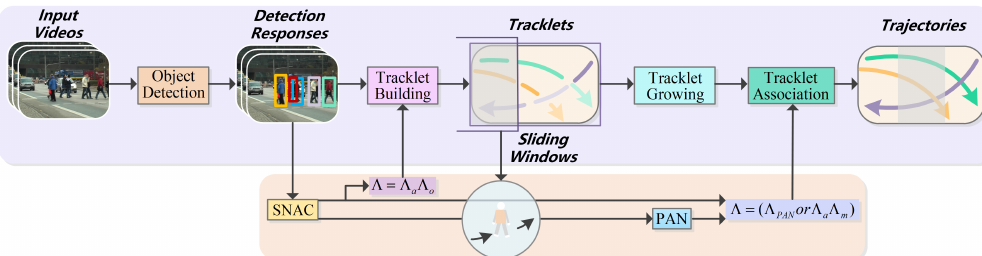
Figure 3. Illustration of the overall online tracking by detection (TBD) framework. In addition to standard inputs and outputs, an online tracking framework is established with new facilities, including an iterative Siamese network with an auto-encoding constraint (SNAC) to learn the detection responses, previous-appearance-next (PAN) to represent the composite features of tracklets, and pre-processing of tracklet growth to cope with short-time detection failures. Finally, a greedy iterative algorithm is used to output robust trajectories in sliding